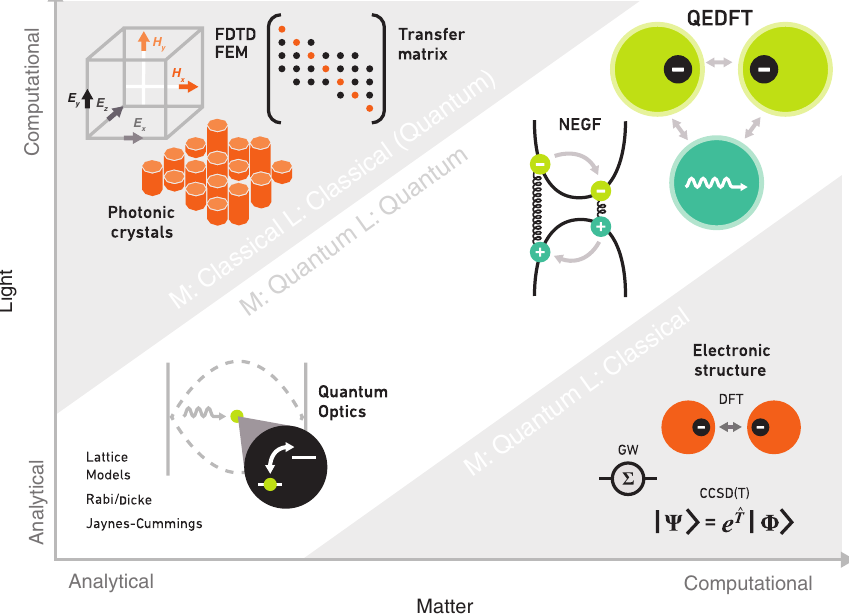
Figure 7: Theoretical methods that treat the light-matter problem can be classified by the level of theory they treat the individual subsystems and from more analytical to more computationally